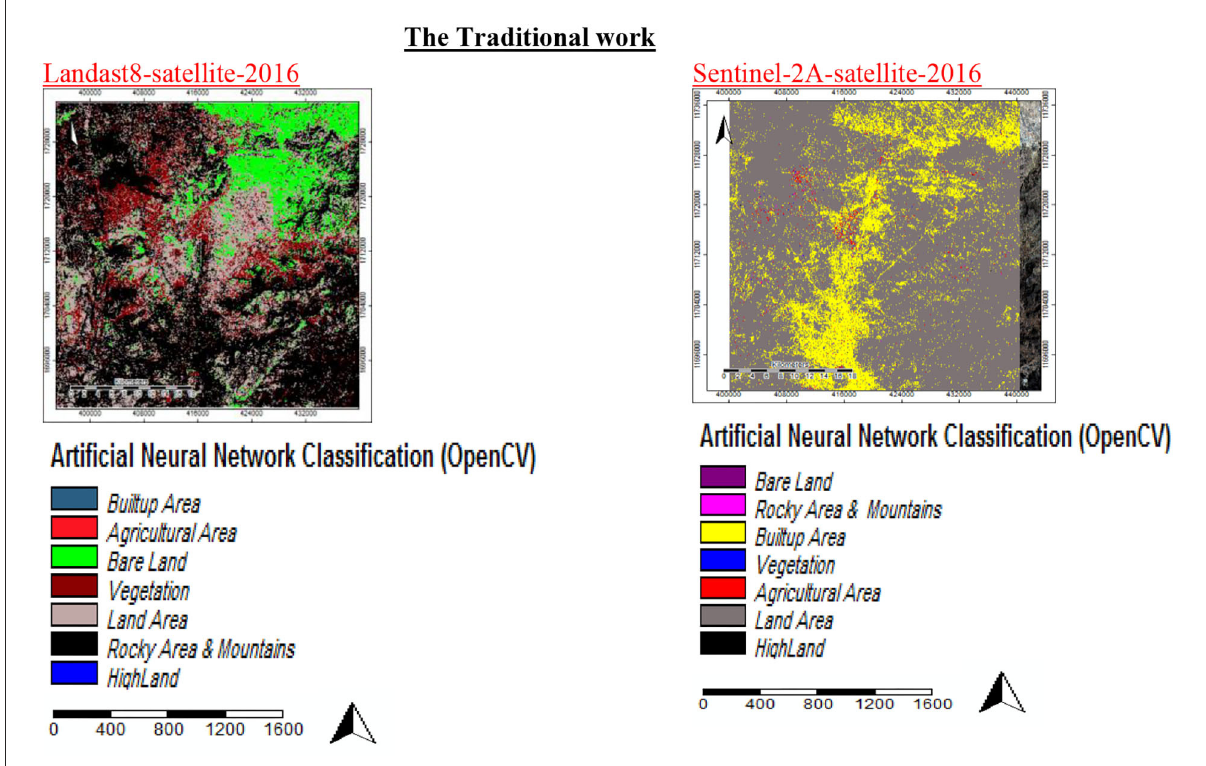
FIGURE7 Classification of land use land cover with ANN classifiers